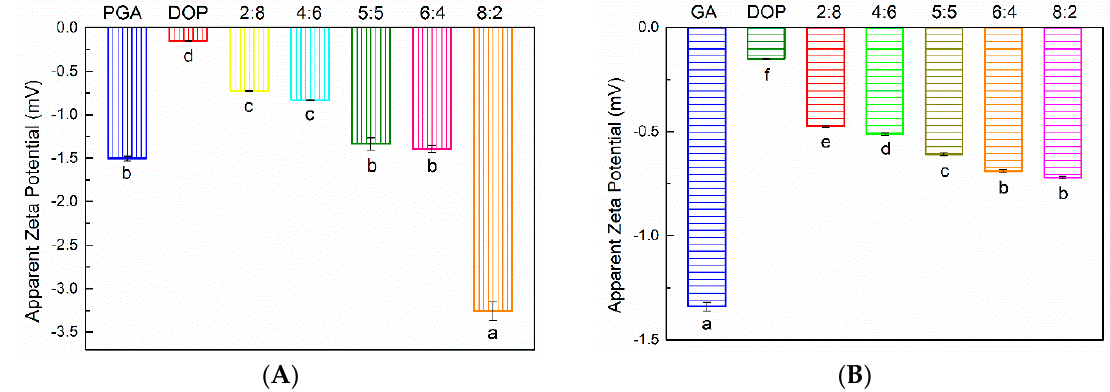
Figure 4. ( A ) The zeta potential of emulsions prepared by compounding polysaccharides of PGA and DOP as emulsifiers (total emulsifier concentration was 1 wt%); ( B ) The zeta potential of emulsions prepared by compounding polysaccharides of GA and DOP as emulsifiers (total emulsifier concentration was 1 wt%), a–f indicate significant differences ( p < 0.01).